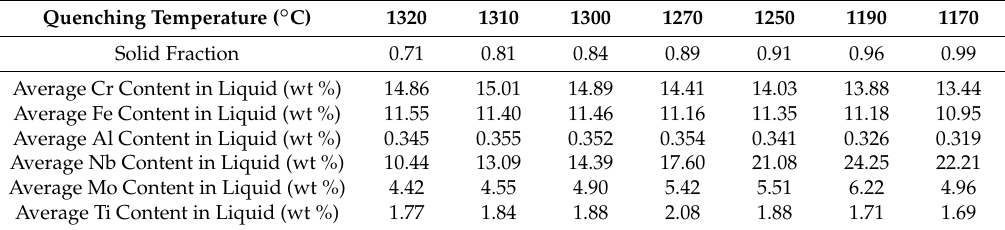
Figure 4. BSE images of the samples at different quenching temperatures: ( a ) 1320 °C; ( b ) 1300 °C; ( c ) 1270 °C; ( d ) 1250 °C; ( e ) 1190 °C; ( f ) 1170 °C. Table 2. Measured solid fraction and EPMA results of each quenched sample.